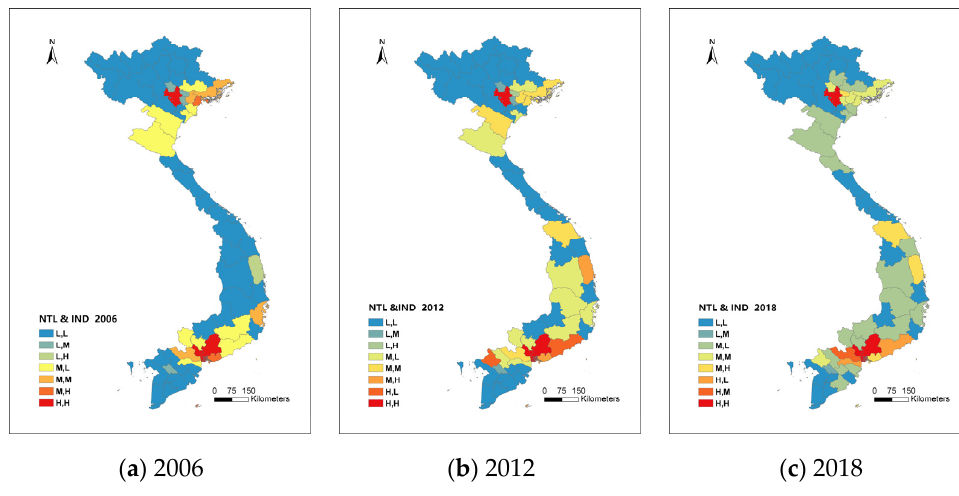
Figure 6. Changes in coupling relationship between NTL-IND from 2006 to 2018.